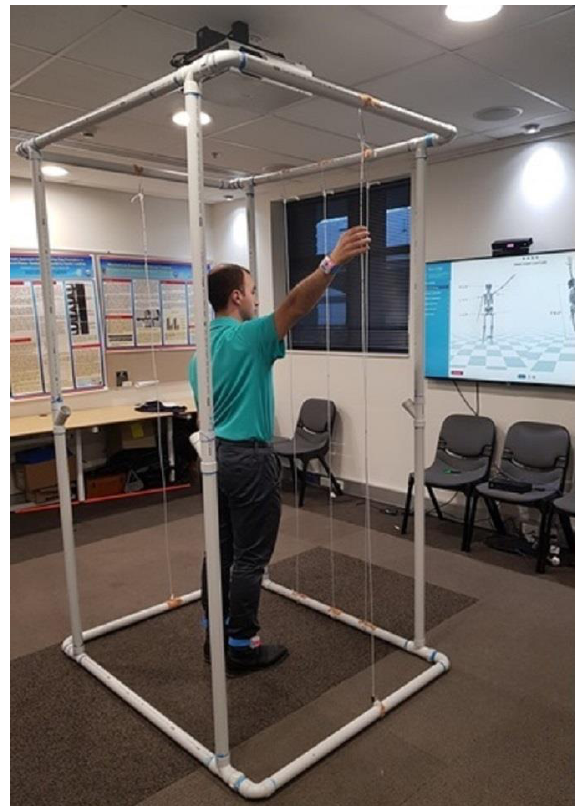
Figure 2. Fixed AROM with a freestanding cage.